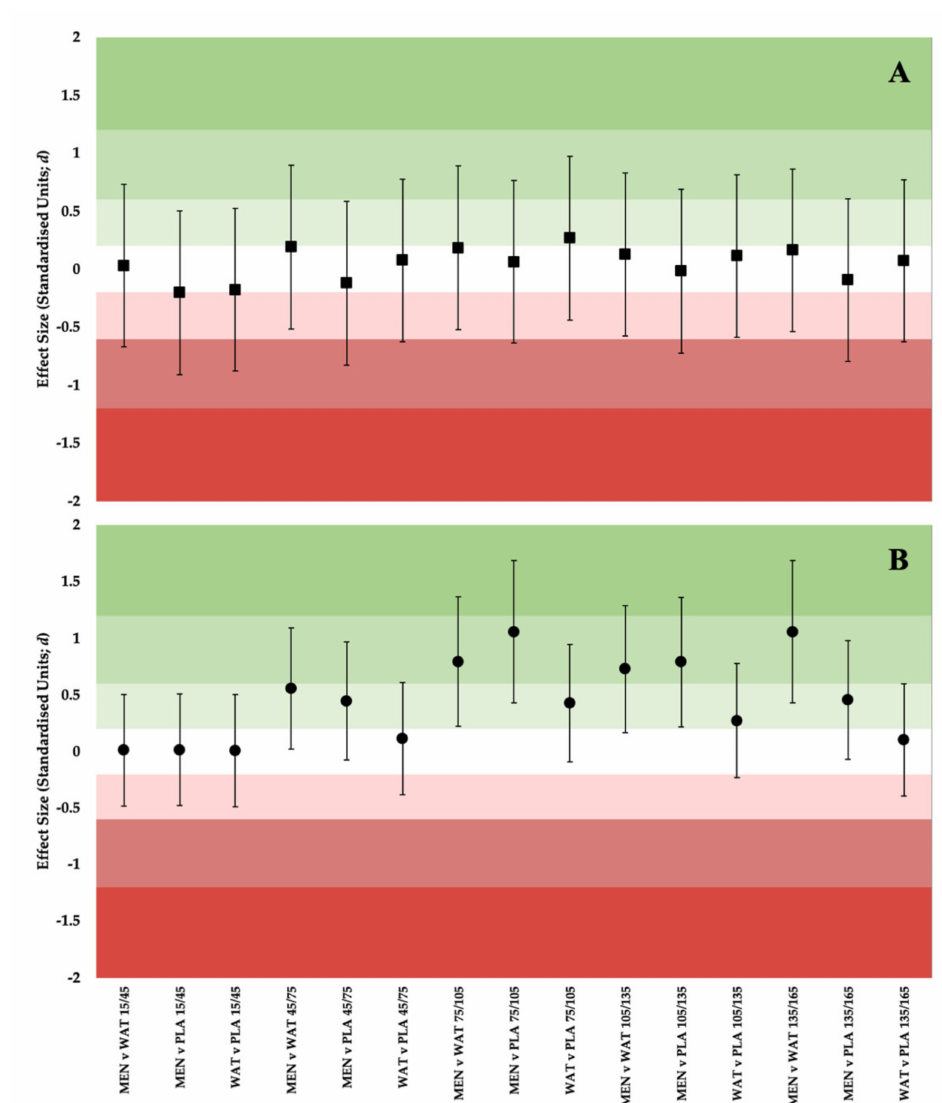
Figure 4. Forest Plot showing ES ± 90% CI at matched time points between solutions for ( A ) Absolute Power; ( B ) Relative